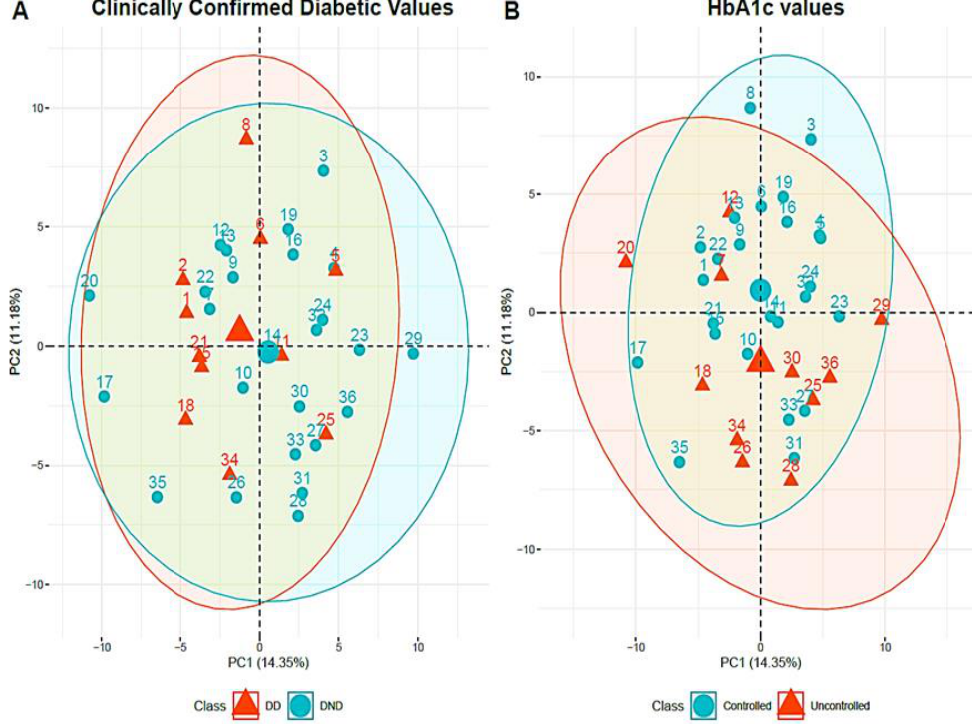
Figure 2. Plots of PCA scores: ( A ) PCA plot based on clinically confirmed diabetic status; ( B ) PCA plot based on latest HbA1c values (controlled if HbA1c value is less than 6.5% and uncontrolled otherwise).